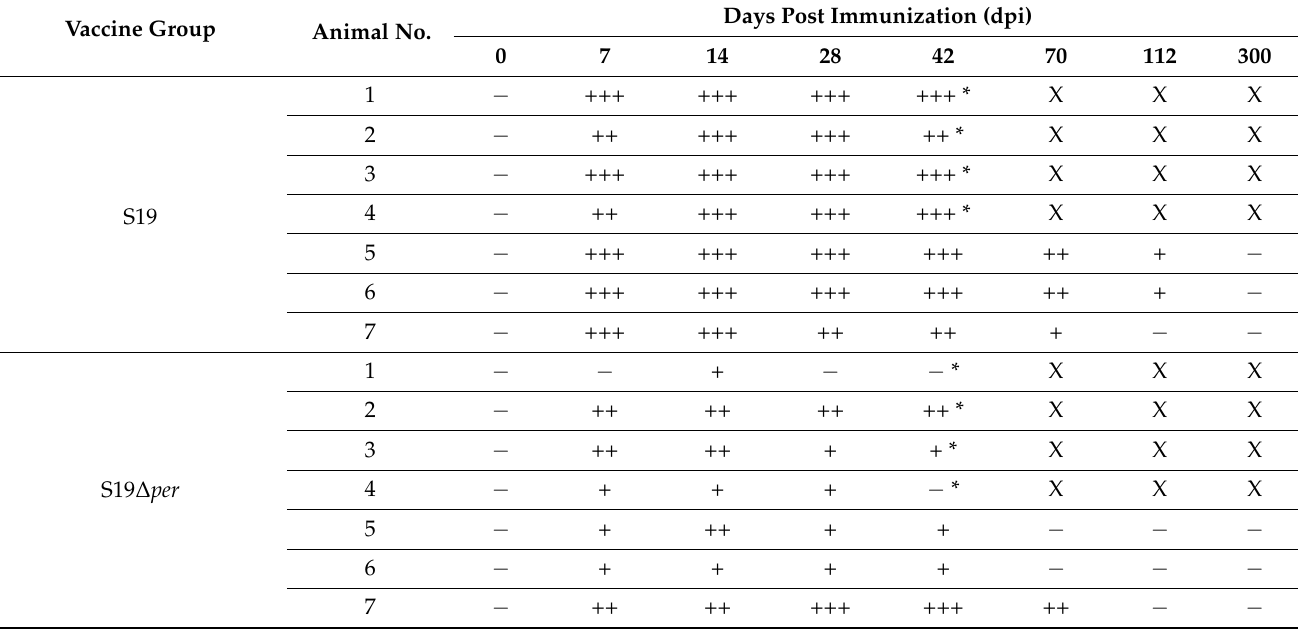
Table 2. Seroreactivity and DIVA status of S19, S19 ∆ per and S19 ∆ per reduced dose immunized animals analyzed by rose bengal plate test